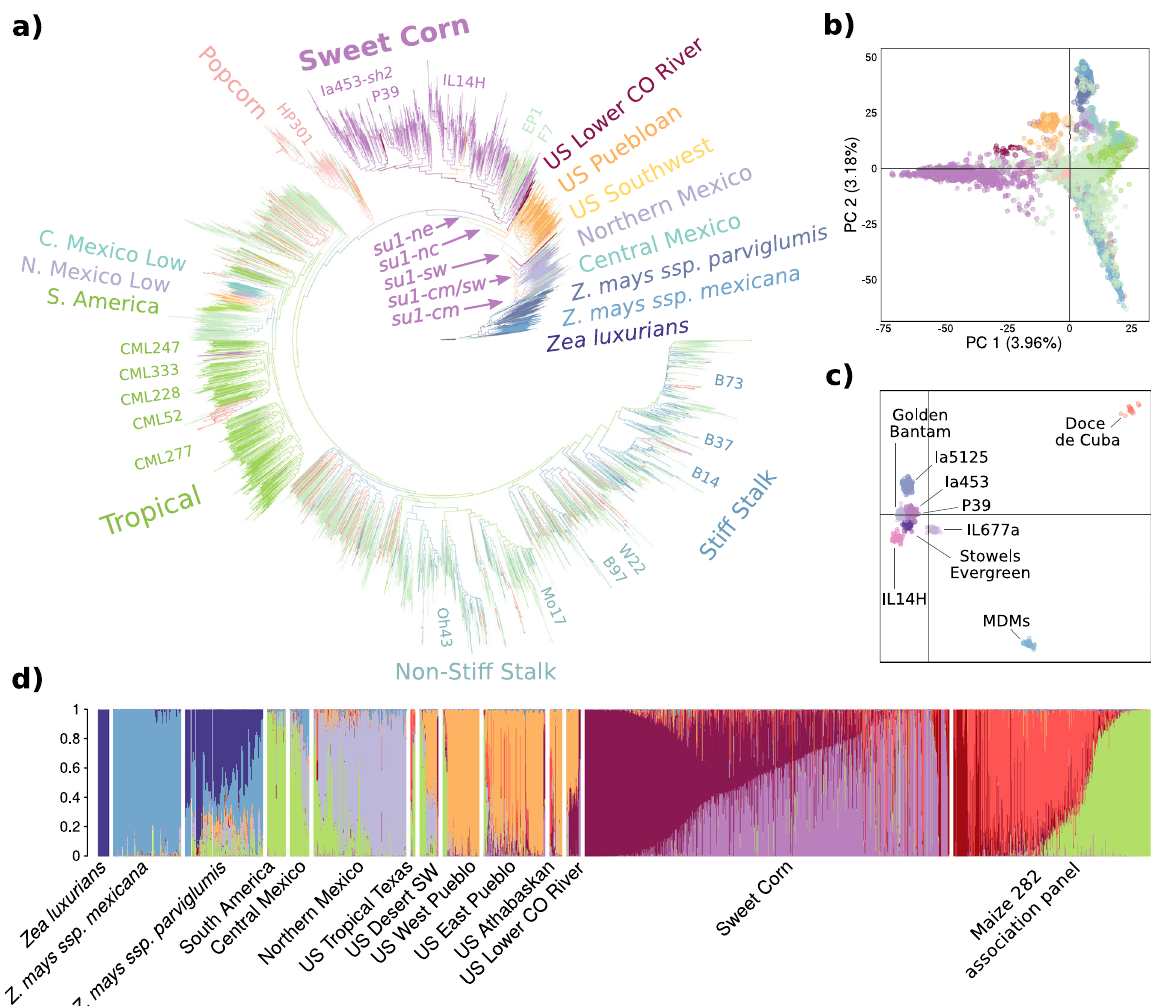
Fig. 3 Phylogenetic relationships and population structures of diverse teosinte and maize accessions. a Phylogenetic tree of teosinte, landraces, sweet corn, and fi eld corn genotypes. b Principal component analysis color-coded as in the phylogenetic tree. c Discriminant analysis of principal components (DAPC) plot with only the sweet corn lines using different colors, highlighting an important line that is representative of each cluster —“ MDMs ” label represent a group of sweet corn lines bred for Maize Dwarf Mosaic Virus. d Bayesian clustering of the population using STRUCTURE with K = 9. Sweet corn and Maize 282 association panel were sorted based on one of their prevalent populations. The other groups were sorted based on the altitude where they were grown according to Swarts et al. 57 . The colors used do not represent the same grouping as panels ( a ) and ( b